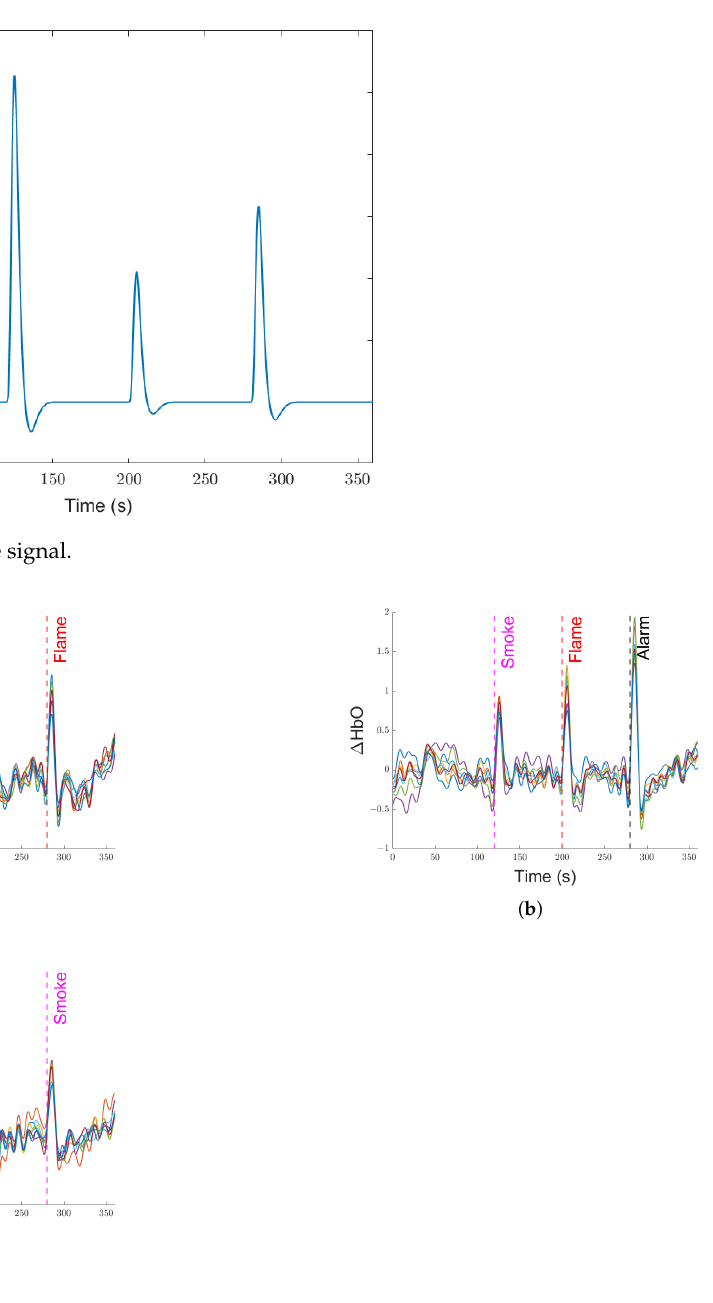
Figure 15. Three cases of filtered ∆ HbO signals. ( a ) Case 1, ( b ) Case 2, ( c ) Case 3. The goal here is to solve the activation coefficient β , defined in Equation (10). It is clarified in Figure 6 that every adjacent two stimuli are set 80 s apart, whereas the HRF lasts 30 s. Therefore, every stimulus can be dealt with separately. Let (cid:126) y j denote an N × 1 column vector that represents the ∆ HbO signal of the j -th channel, where N denotes the number of time points. (cid:126) f i is exactly the same as f i ( t ) in Equation (9), written as an N × 1 column vector. β ij represents the activation coefficient with respect to the i -th stimulus and the j -th channel. Equation (10) can hence be rewritten as the following equation, where ε denotes